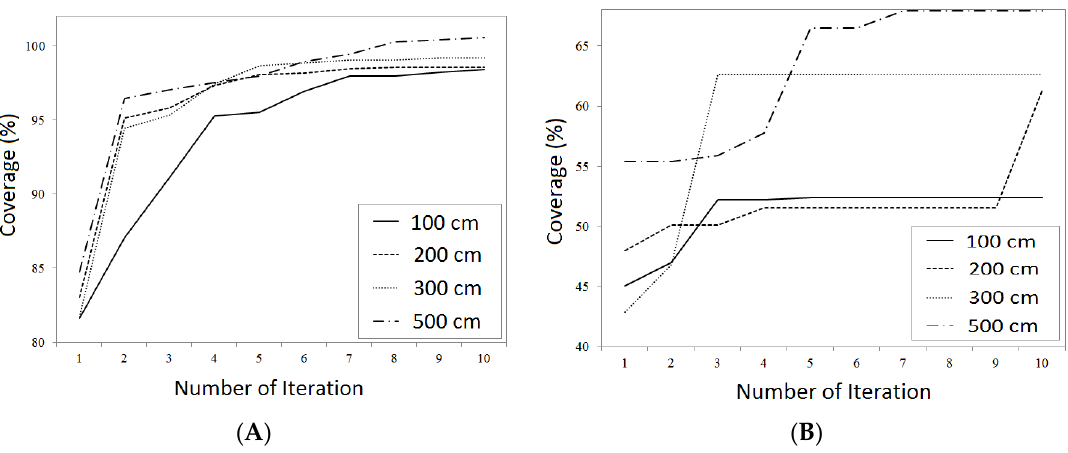
Figure 15. Convergence diagram based on VFCPSO algorithm for: ( A ) two-dimensional; and ( B ) three-dimensional raster models.